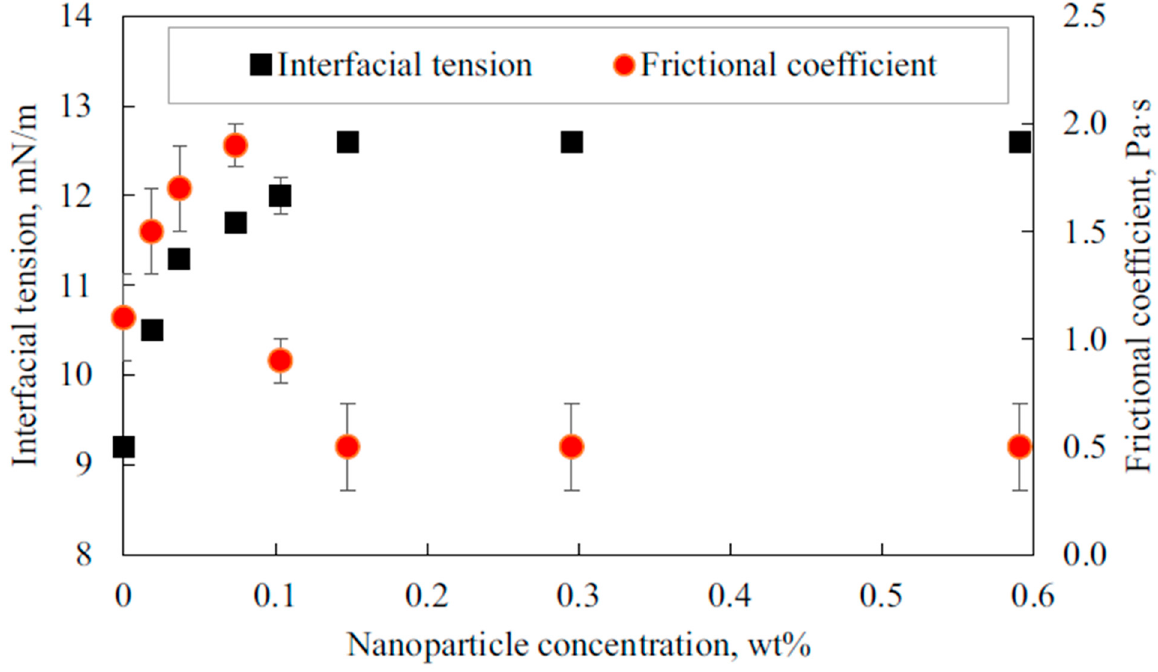
Figure 15. Interfacial tension and frictional coefficient at different nanoparticle concentrations. Reprinted with permission from [53]. Copyright 2018 Elsevier.